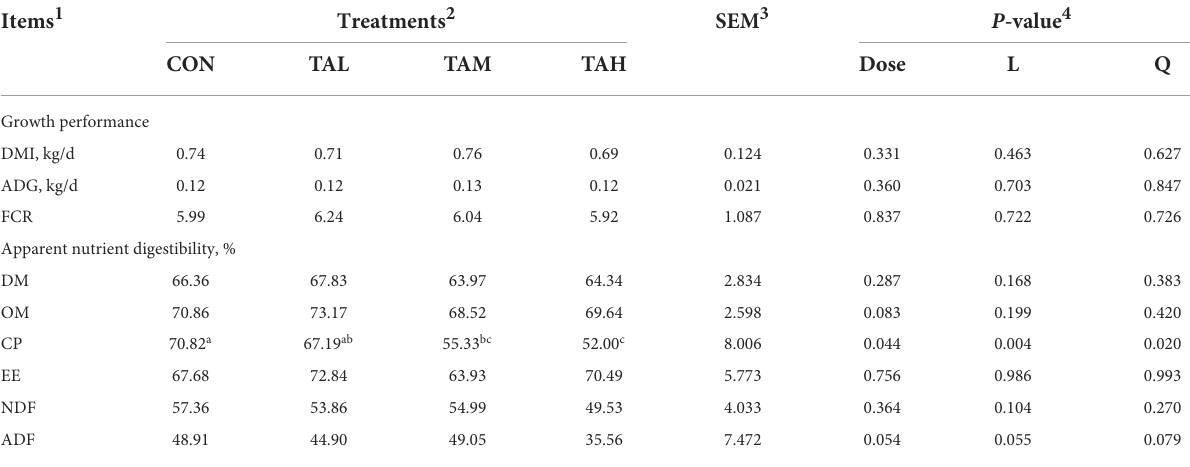
TABLE 2 Effects of tannic acid at different doses on growth performance and apparent nutrient digestibility of black goats. Items